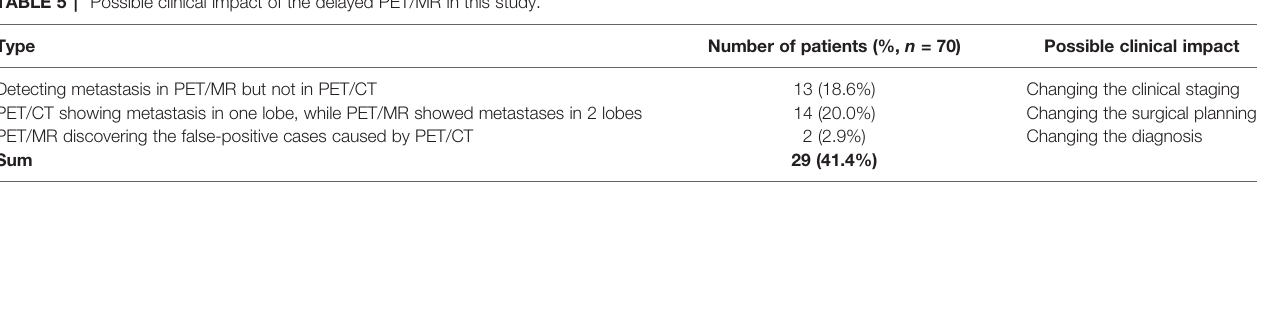
TABLE 6 | Trials involving the comparison between PET/CT and PET/MR in liver metastasis.